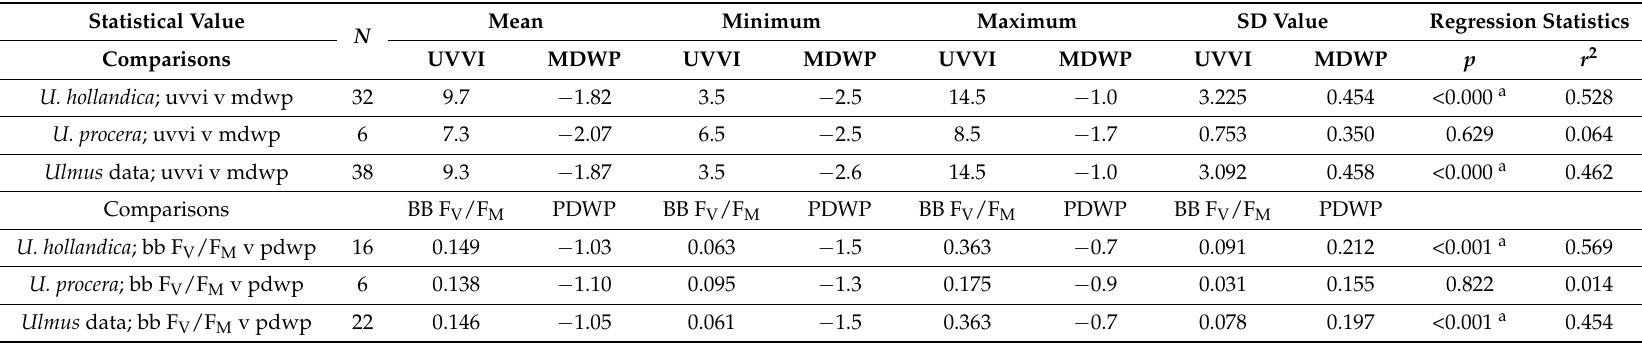
Table 1. Summarised results from basic statistics and simple linear regression analyses comparing pre-dawn water potentials with the urban visual vitality index and midday water potentials with branch bark F v F m in both Ulmus × hollandica and Ulmus procera . Statistical Value Mean Minimum Maximum SD Value Regression N